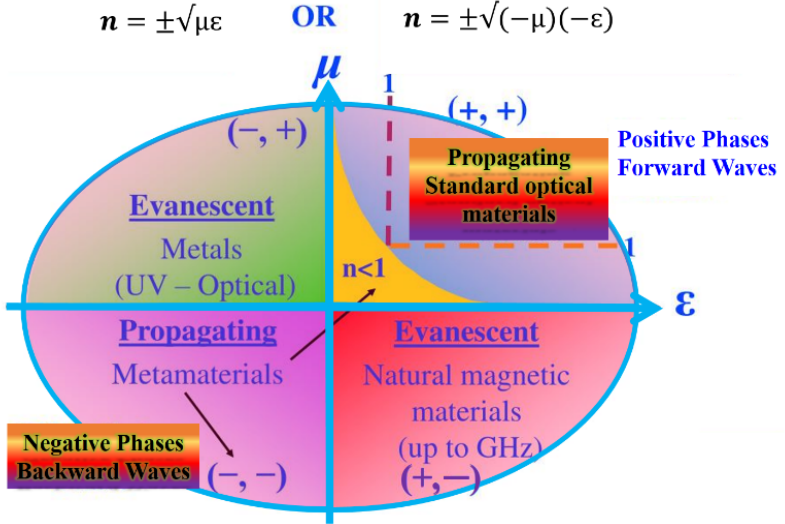
Figure 2. Summary of the metamaterial’s classification based on their permittivity ( ε ) and permeability ( μ ). Adapted from Ref. [16].